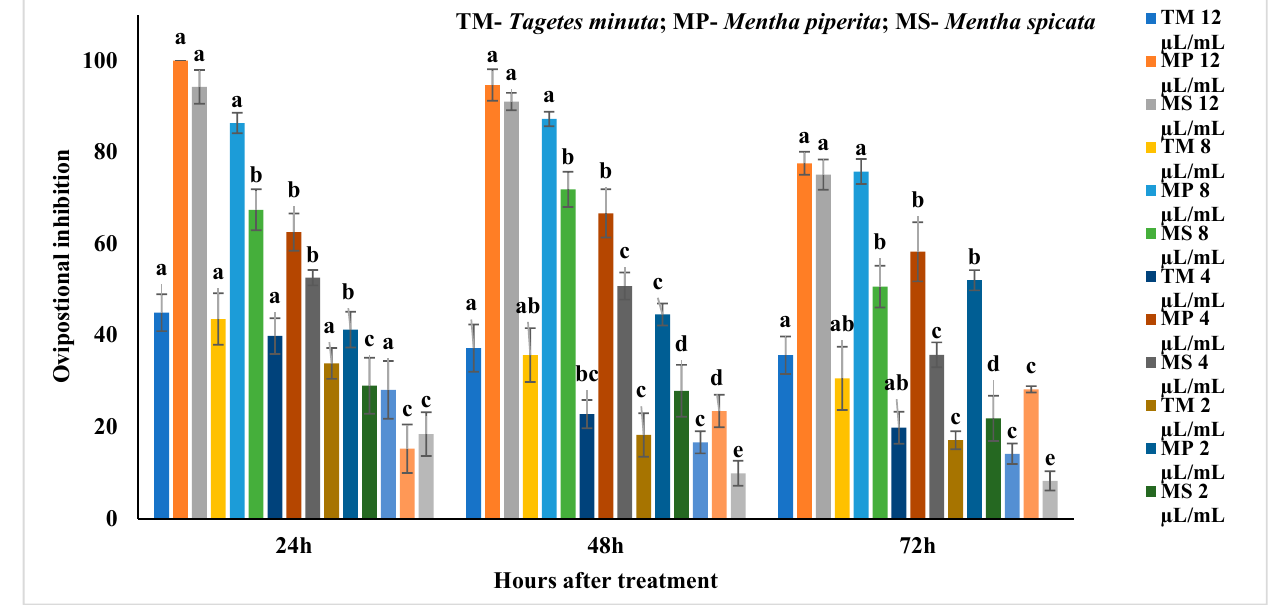
Figure 5. Ovipositional inhibition of essential oils against Callosobruchus maculatus ; Means followed by the same letter within the error bars are not statistically different by Tukey ( p ≤ 0.05). 2.6. Comparative Toxicity, Synergistic, Repellence and Ovipositional Deterrence Activities of EOs and Its Combination against C. chinensis and C. maculatus